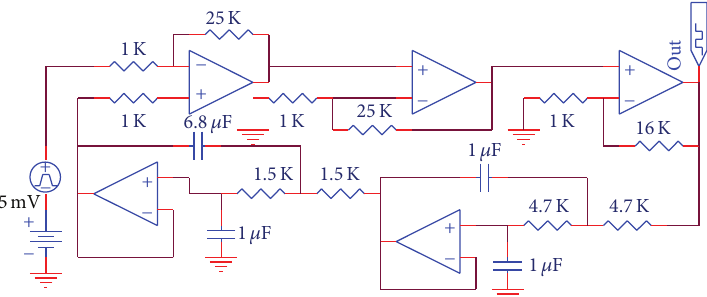
Figure 10: Improved DC coupling circuit with low frequency servo loop based on discrete components.